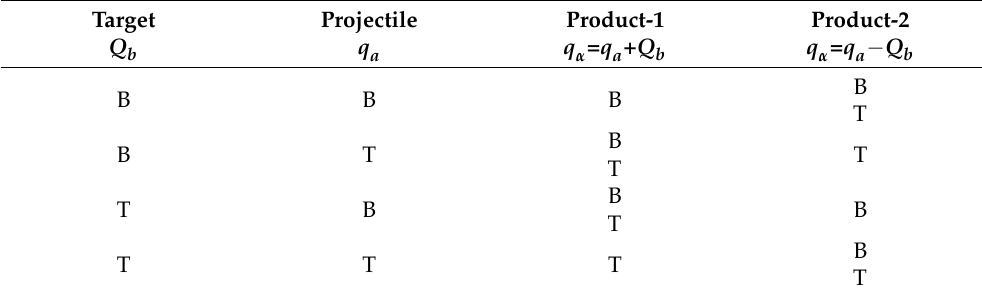
Table 1. Possible mass state transitions. “B” stands for bradyon and “T” stands for tachyon. The subscripts a , b , α denote the projectile, the target, and the product particle, respectively, the variables q and Q denote the corresponding masses. See text for